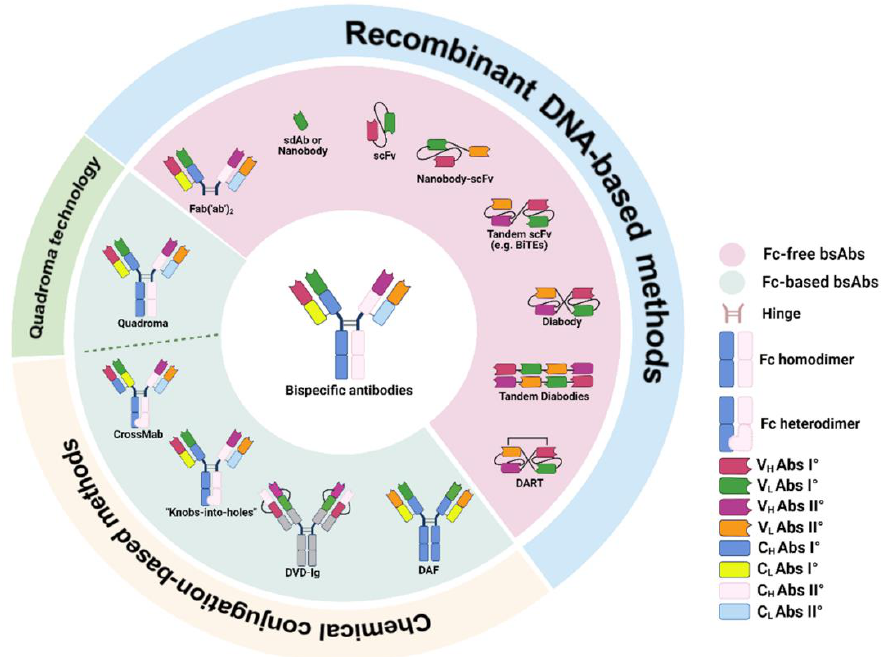
Figure 2. Molecular formats of bispecific antibodies. According to the Fc domain, bsAbs can be divided into Fc-free bsAb and Fc-based bsAb format molecules further classified based on their differential methods of development. Among the “zoo” of bsAbs, representation of bsAbs described in the text is shown.